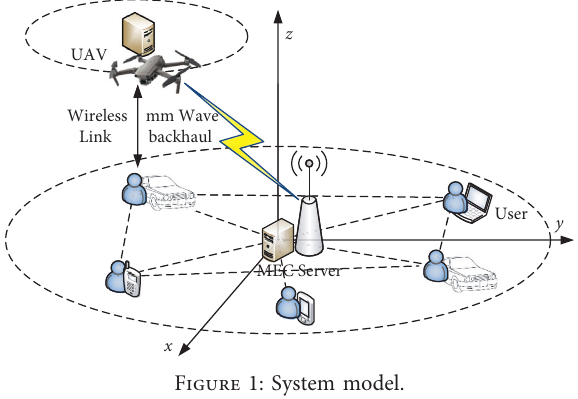
Figure 1: System